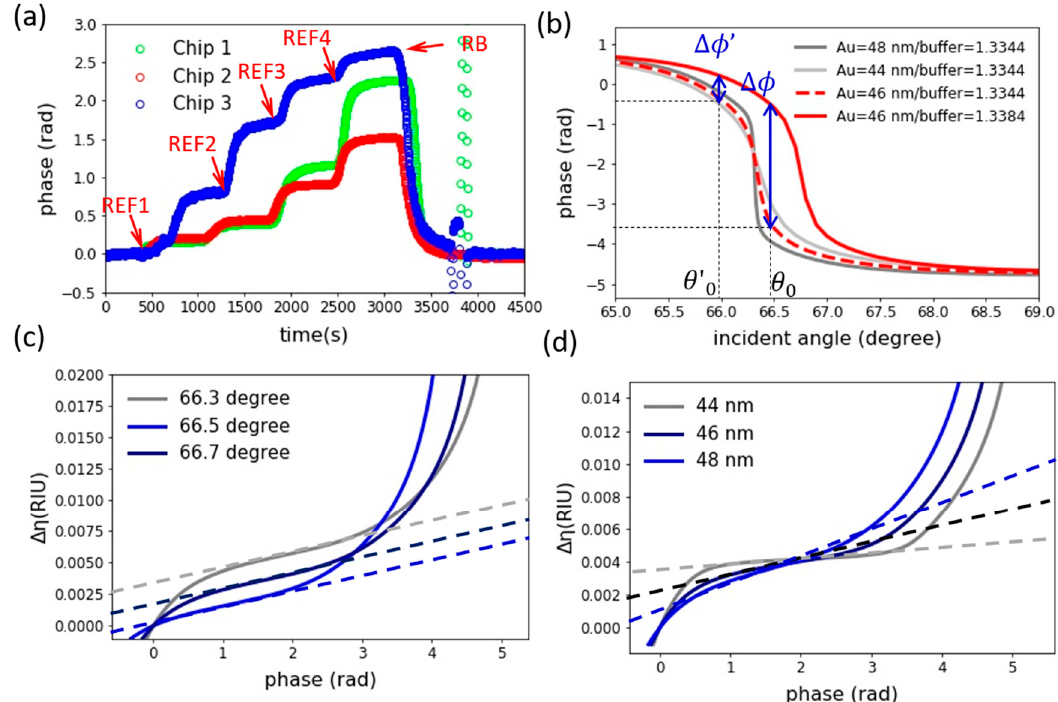
Figure 4. ( a ) sensorgram of pSPR chips upon different reference solutions. ( b ) Angle resolved phase spectrum of SPR simulated under five-layer Fresnel modeling. ( c ) The mapping function established via the five-layer Fresnel modeling under a fixed gold film thickness of 46 nm, with varying incident angle from 66.3 to 66.5 degree. ( d ) A mapping function established under fixed incident angle, with film thickness varies from 44 nm to 48 nm.